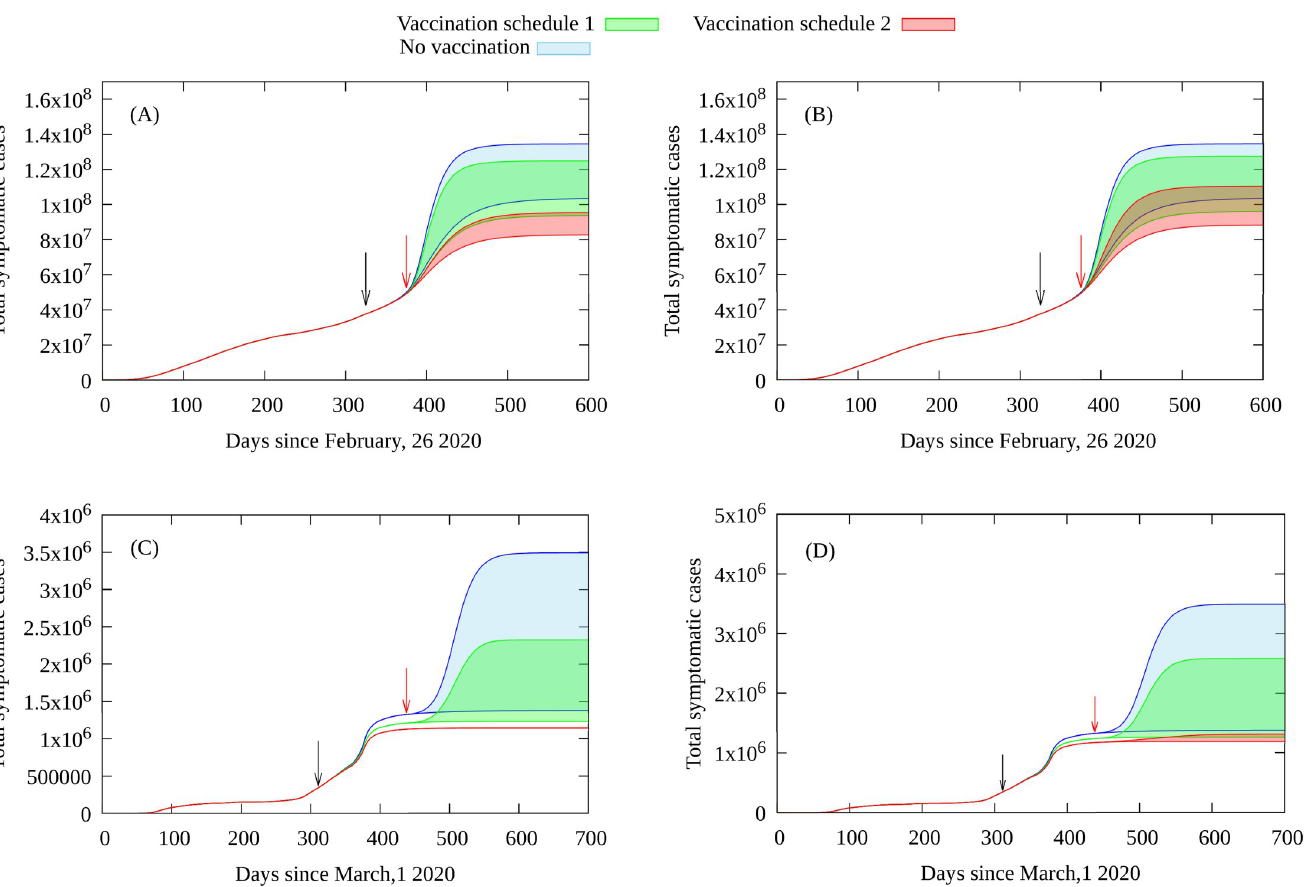
Fig 3. Total number of deaths obtained from the fitted epidemiological model. The results are for two different vaccine efficacy scenarios for Brazil A) e v = 95%, B) e v = 70%, and for Portugal with C) e v = 95%, D) e v = 70%. Black arrows indicates the beginning of each vaccination plan while red arrows the moment when superspreaders return to full activity, with α = 3 to α = 10 times more contacts than typically for its age group (30 to 39 years old). The shaded blue area gives the prognostics in the absence of any vaccination. The green area gives the prognostics with vaccination starting with individuals aged 60 years and older and then vaccinating the remaining population in descending order of age group (vaccination plan 1). The red region corresponds to vaccination plan 2 starting with the superspreaders and then proceeding in the same order as in vaccination plan 1. Each shaded region is delimited by the evolution with contact factors α = 3 and α = 10.